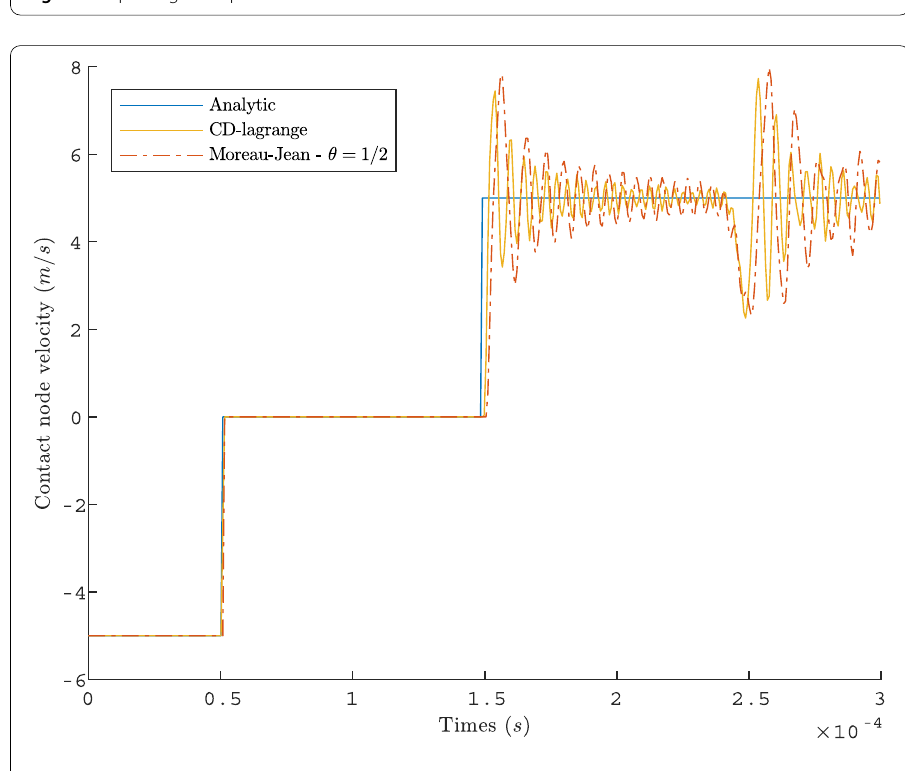
Fig. 21 Impacting bar—velocity of contact